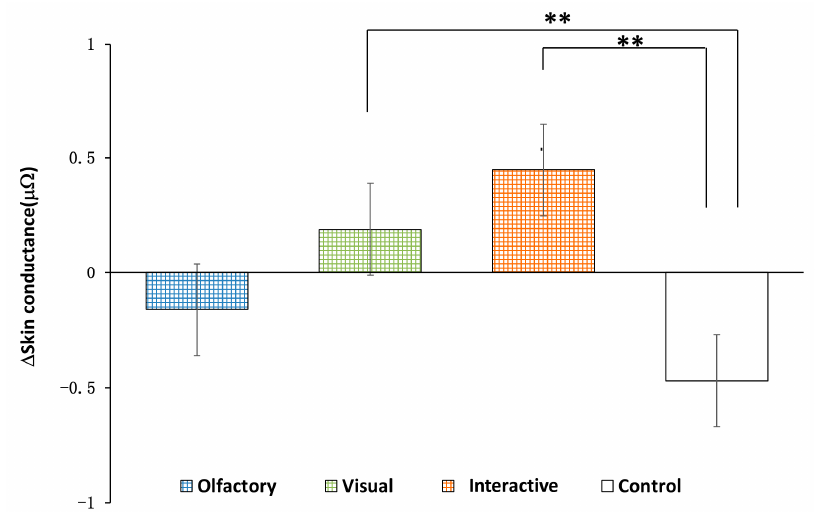
Figure 4. Effects of different stimulation types on human skin conductivity (SC). ** indicates that the difference between the two was extremely significant, p < 0.01.